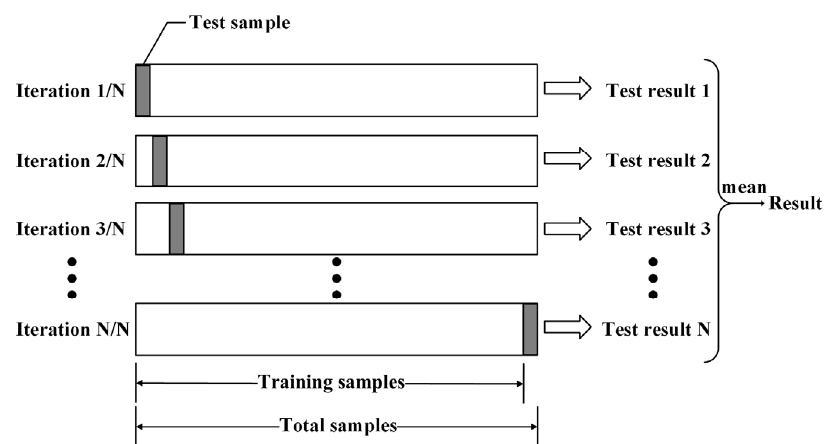
Figure 5. Schematic diagram of LOO ‐ CV principle.